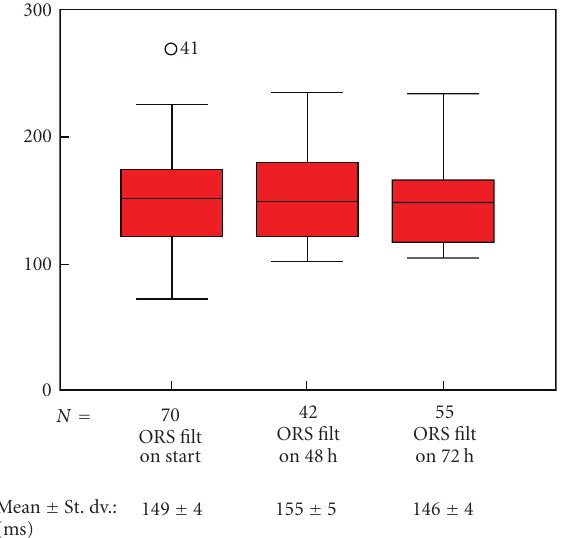
Figure 2: Changes of filtered QRS duration after onset of levosi-